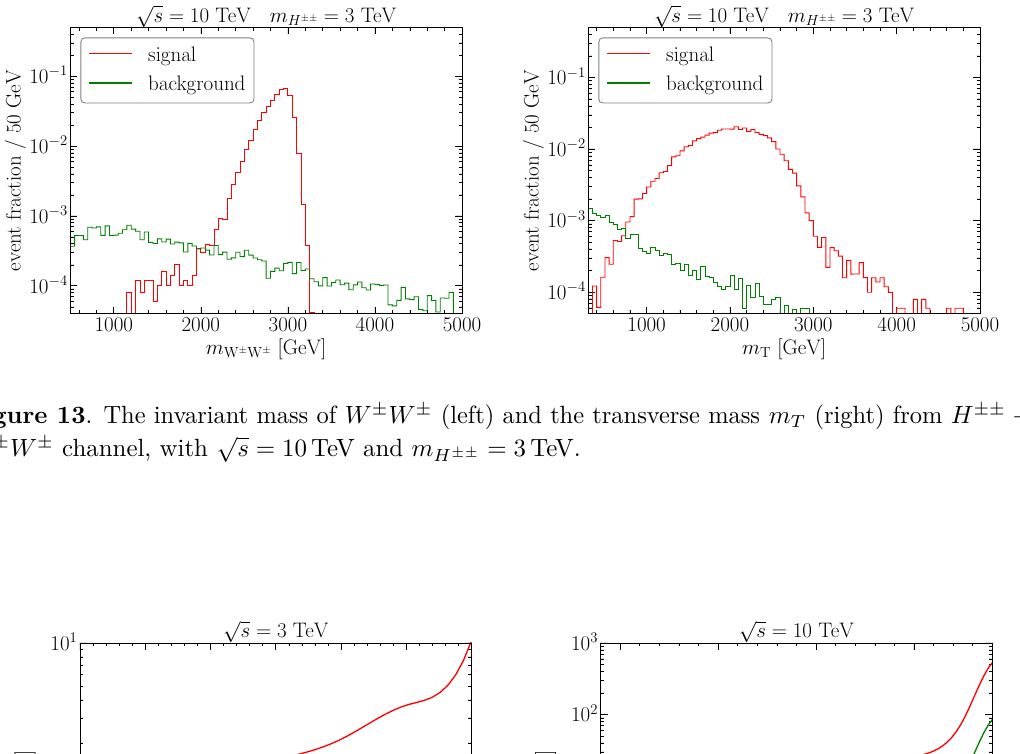
Figure 14 . The integrated luminosities for 2 σ (green) and 5 σ (red) significance versus m H ++ H −− → W + W + W − W − channel at muon colliders with